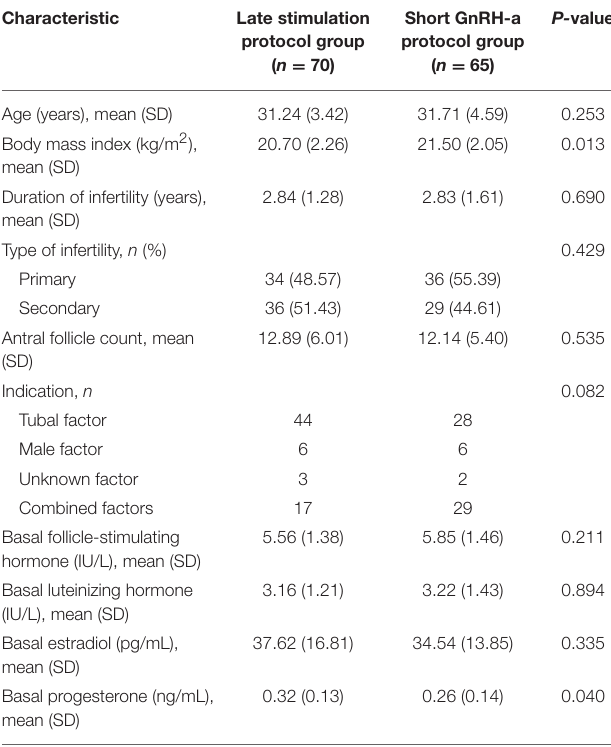
TABLE 1 | General characteristics of patients undergoing in vitro fertilization/ intracytoplasmic sperm injection treatment.